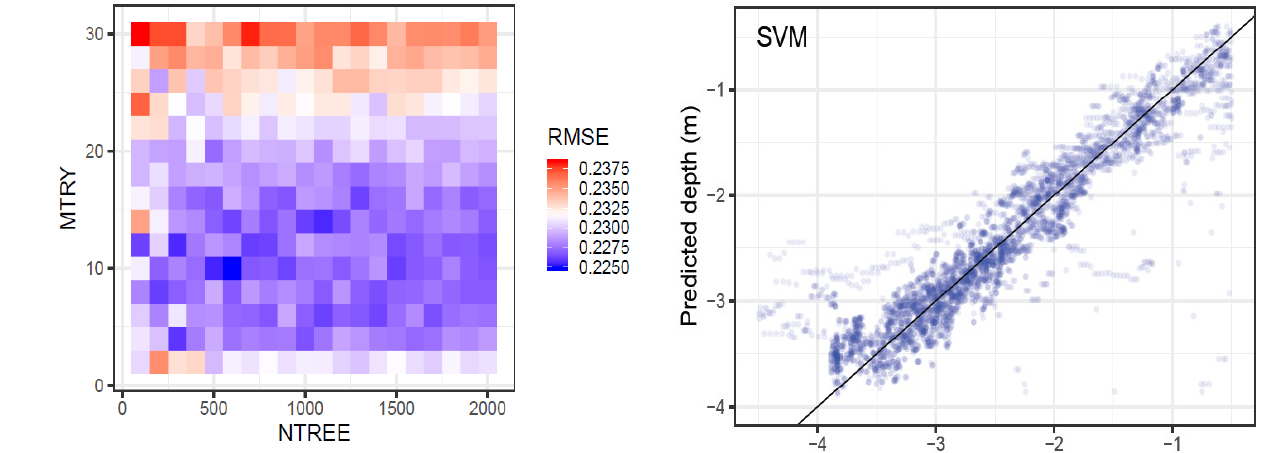
Figure 4. RMSE variations depending on mtry and ntree